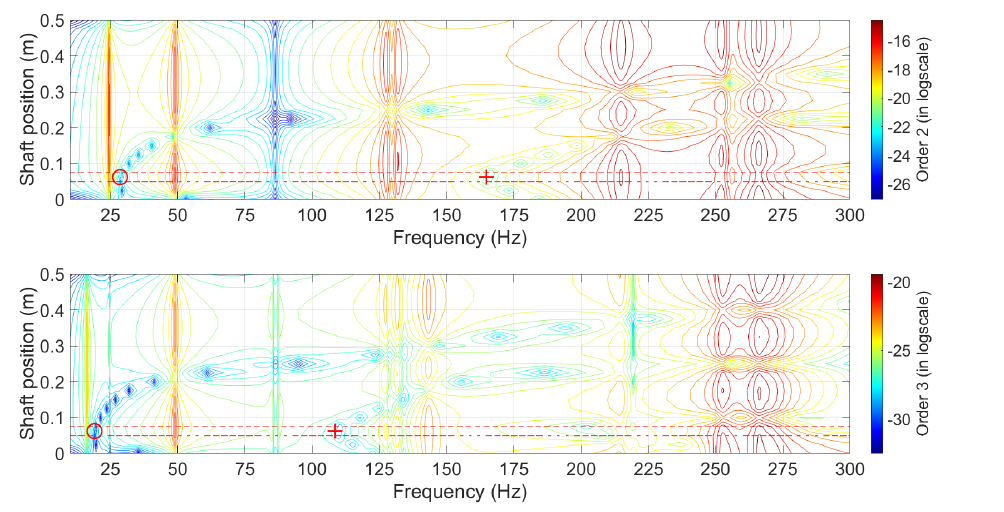
Figure 7. Case 3—Identification of the crack location based on the antiresonances of orders 2 and 3 (results are drawn for the vertical amplitudes in